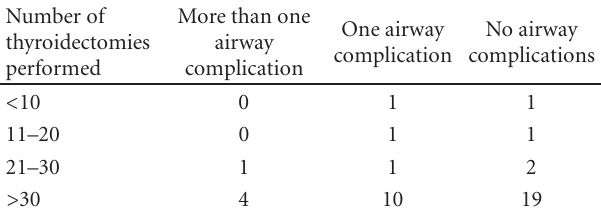
Table 2: The number of thyroidectomies performed annually compared to the frequency of airway